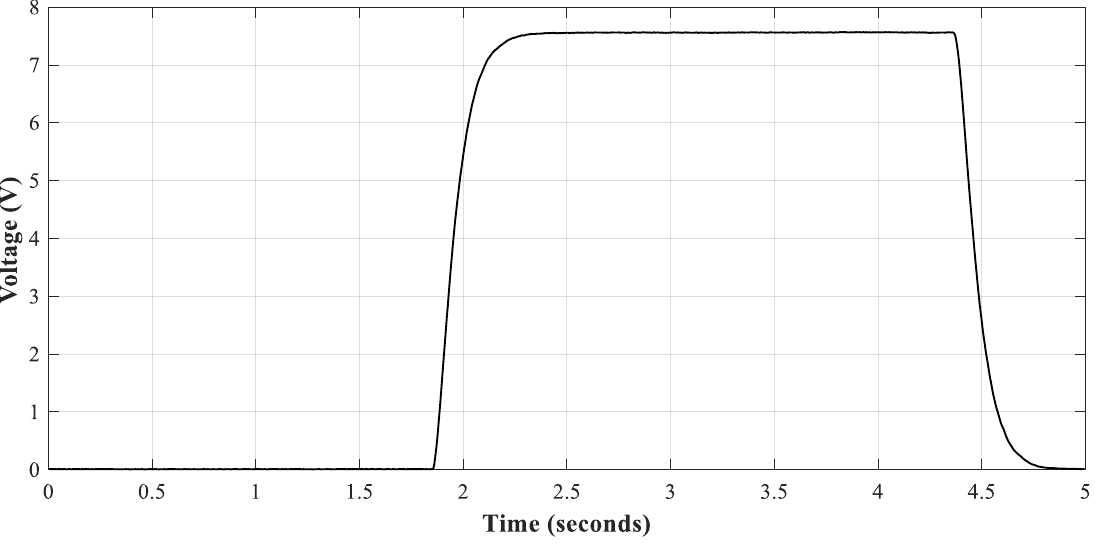
Figure 6. Charging and discharging cycle of electrolytic capacitor.